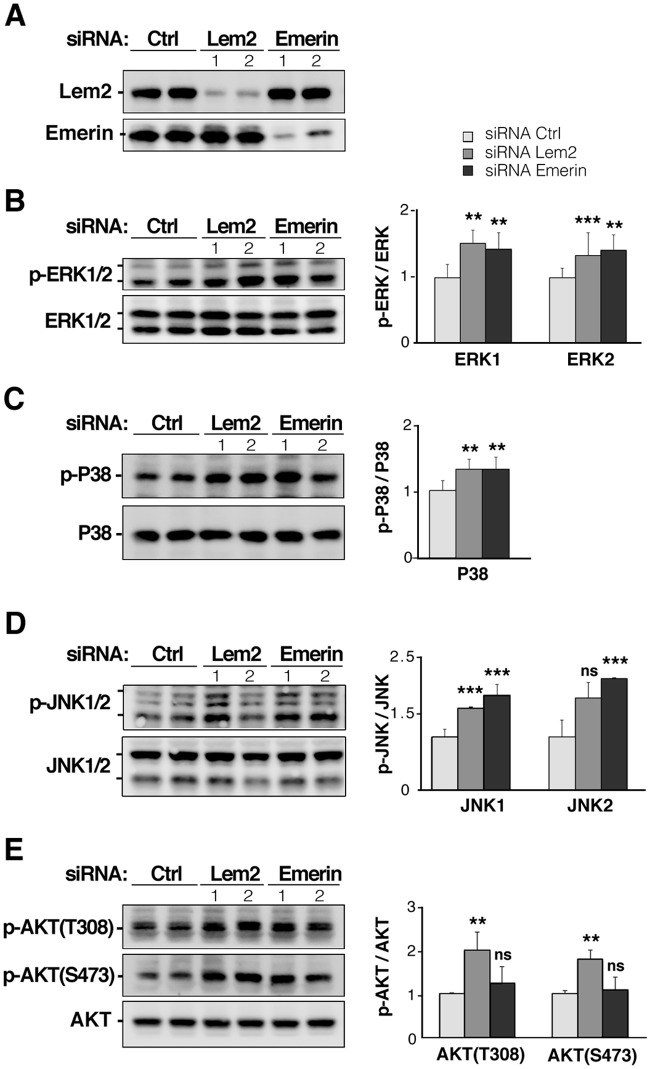
Activation of various signaling pathways in C2C12 cells by knockdown of Lem2 or emerin.(A) Immunoblot showing expression of Lem2 and emerin in C2C12 cells transfected with control (Ctrl) siRNA or either of two different siRNAs targeting Lem2 or emerin mRNA. (B-D) Western blot analysis of the phosphorylated and total levels of ERK1/2 (B), P38 (C), JNK1/2 (D), and AKT at Tyr307 and Ser473 phosphorylation sites (E). Graphs show plots of band intensities. Bars indicate the ratio of phosphorylated protein to non-phosphorylated protein normalized to Ctrl. Values are mean ± standard deviations for n = 4 samples per group (*p < 0.0005, **p < 0.005, ***p < 0.05, ns “not significant”).